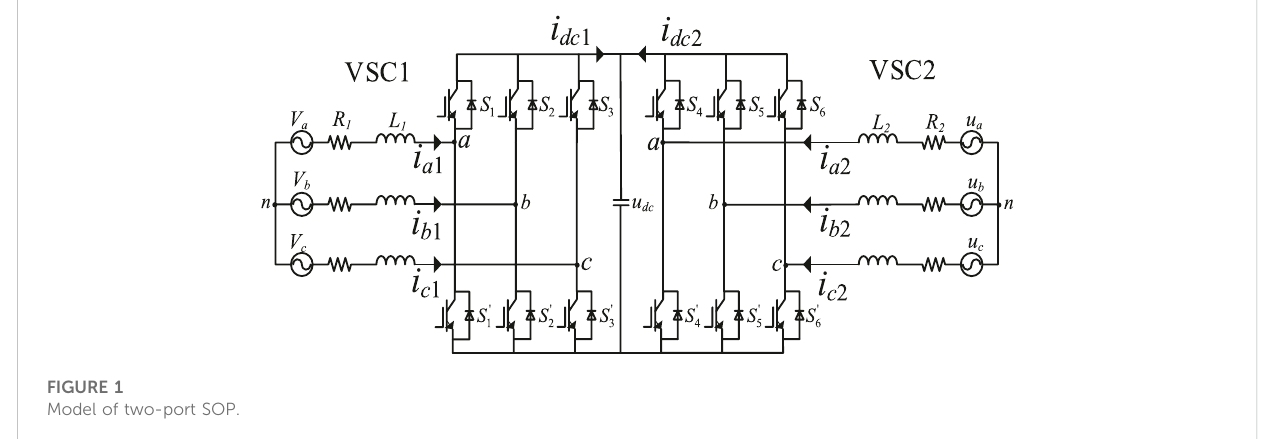
Model of two-port